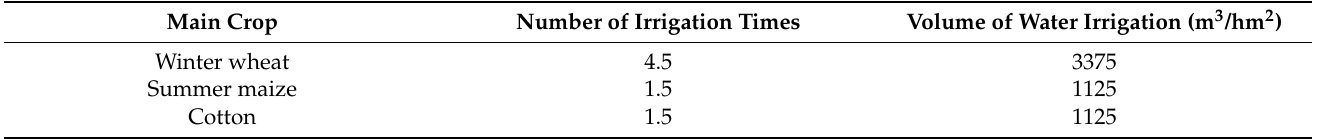
Table 2. Irrigation water consumption of the main crops in Quzhou